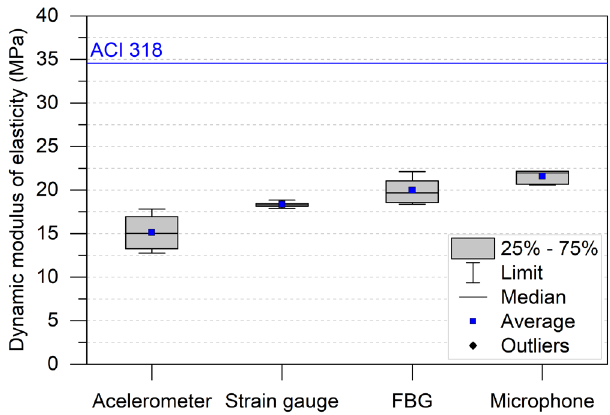
Figure 17. Dynamic elastic modulus of the mortar